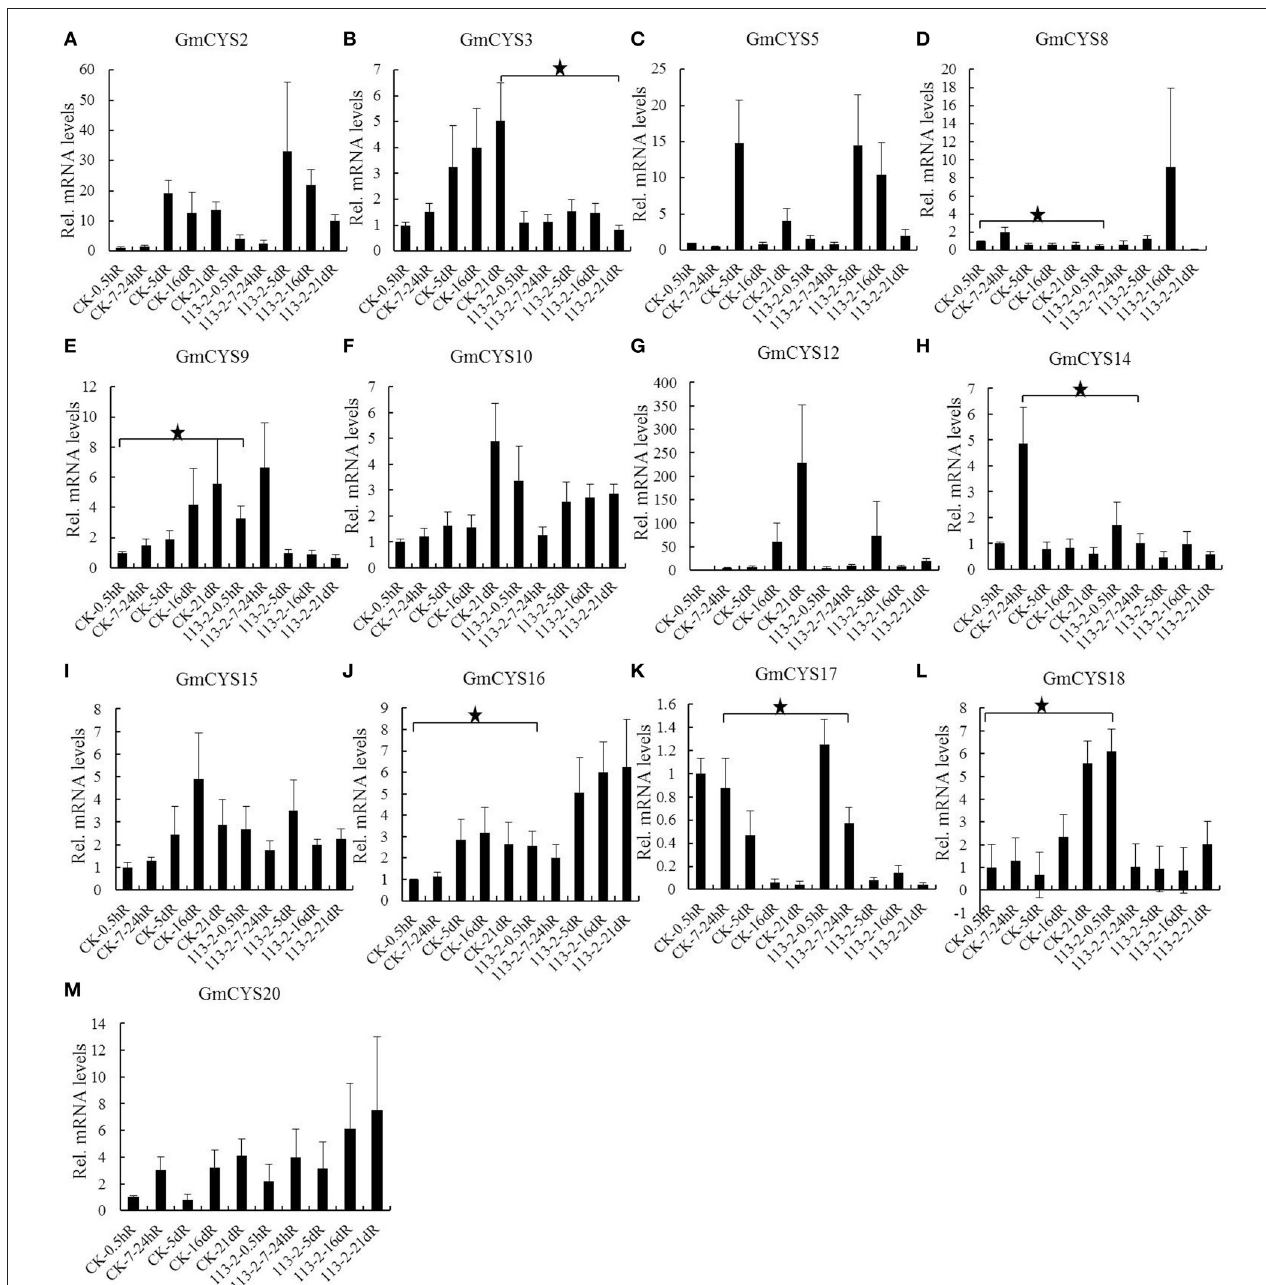
FIGURE 4 | Expression profile of cystatins family genes in soybean roots with and without inoculation of B. japonicum strain 113-2 at five post-inoculation time points. Three biological replica samples were used to detect the expression levels of 13 cystatins. Relative expression levels of each cystatin gene were obtained by qPCR and normalized to the average expression level of soybean reference gene QACT, and calculated using the expression level in CK-0.5 hR as control. Student’s t -test was done using software SPSS Statistics 17.0 and data are presented as the mean ± SE of 9 or 10 independent replicate experiments. “ ⋆ ” indicates statistical difference between the inoculated roots and CK roots ( t -test, p < 0.05). (A) GmCYS2. (B) GmCYS3. (C) GmCYS5. (D) GmCYS8. (E) GmCYS9. (F) GmCYS10. (G) GmCYS12. (H) GmCYS14. (I) GmCYS15. (J) GmCYS16. (K) GmCYS17. (L) GmCYS18. (M) GmCYS20.